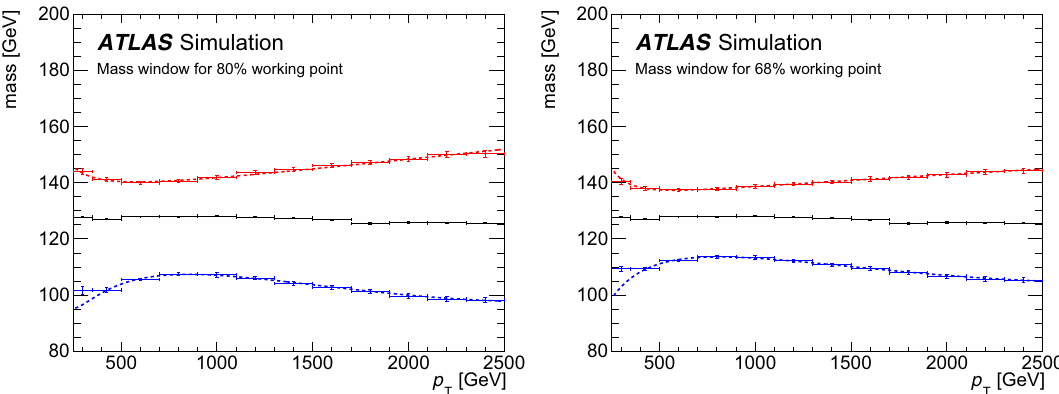
Fig. 5 The Higgs-jet mass window interval for a loose (left) and a tight (right) working point. The dashed lines show a fit to the derived intervals (blue and red markers) as a function of the Higgs-jet p T . The black markers show the position of the maximum of the Higgs-jet mass